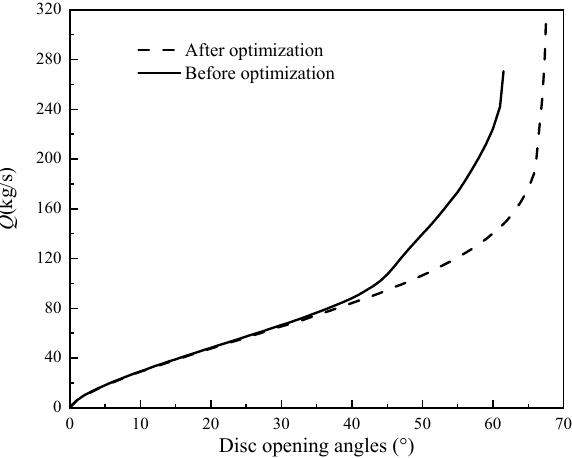
Figure 21. Comparison of opening flow characteristics before and after optimization.